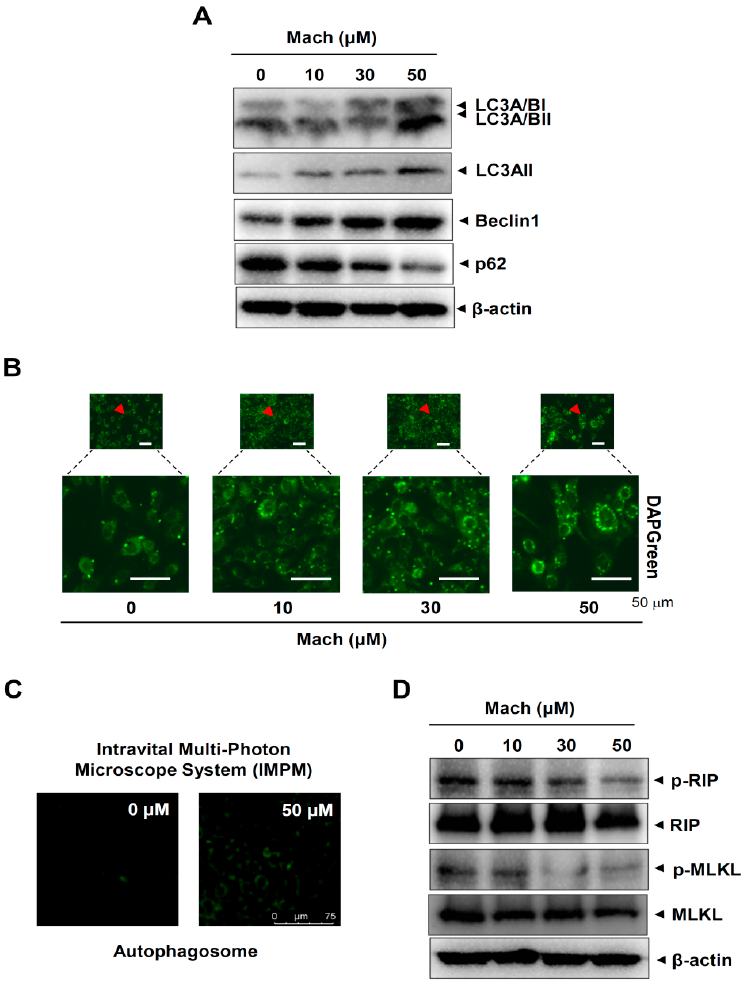
Figure 6. Effects of Mach on autophagy and necroptosis in human YD-10B OSCC cells. ( A ) Western blotting of LC3A/BI, LC3A/BII, LC3AII, Beclin1, p62, and β -actin levels. ( B , C ) DAPGreen-stained autophagosomes were imaged using a fluorescence microscope (arrowheads: magnified regions) ( B ) and an intravital multi-photon microscope system (IMPM) ( C ). ( D ) Western blotting of phospho- RIP (p-RIP), RIP, phospho-MLKL (p-MLKL), MLKL, and β -actin levels. Data are representative of the results from three separate experiments. Statistical significance was analyzed using Student’s unpaired t -test.